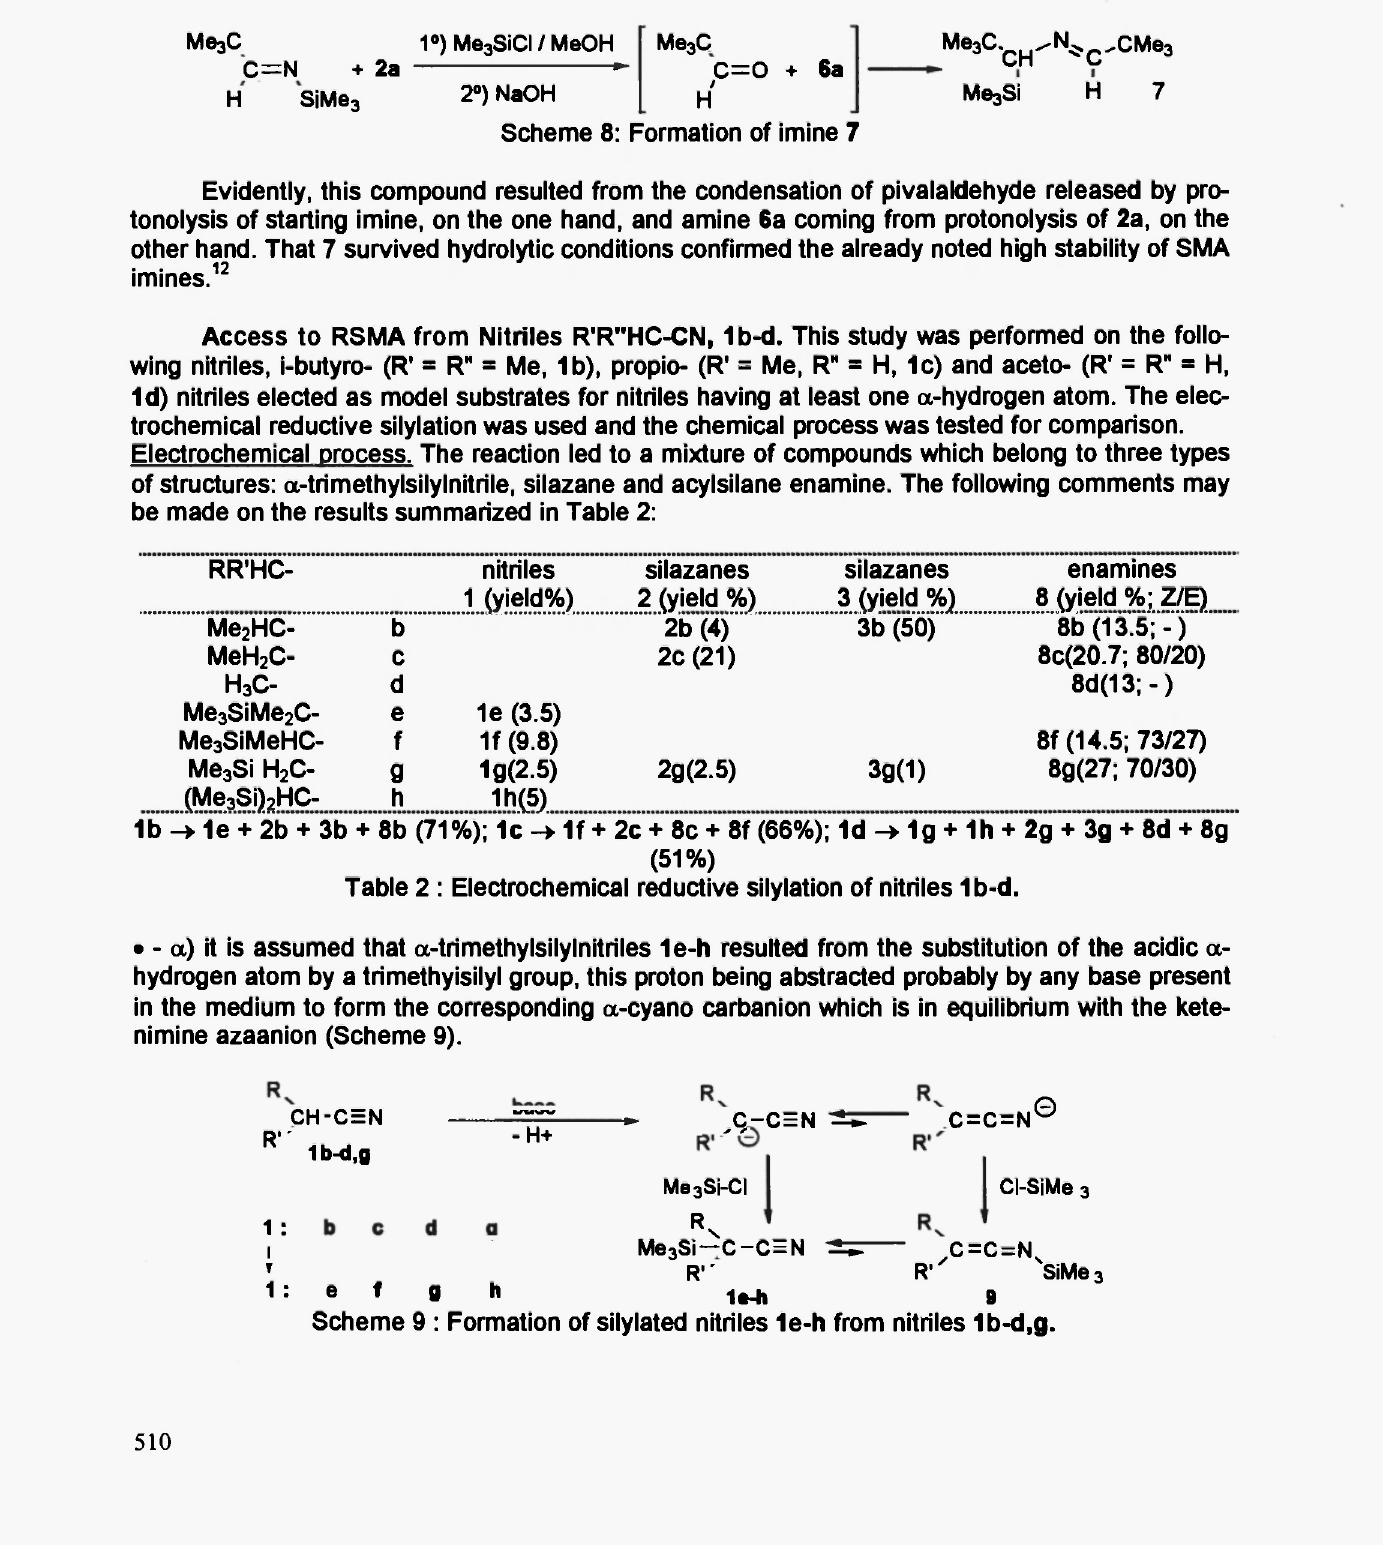
Scheme 9 : Formation of silylated nitriles 1e-h from nitriles